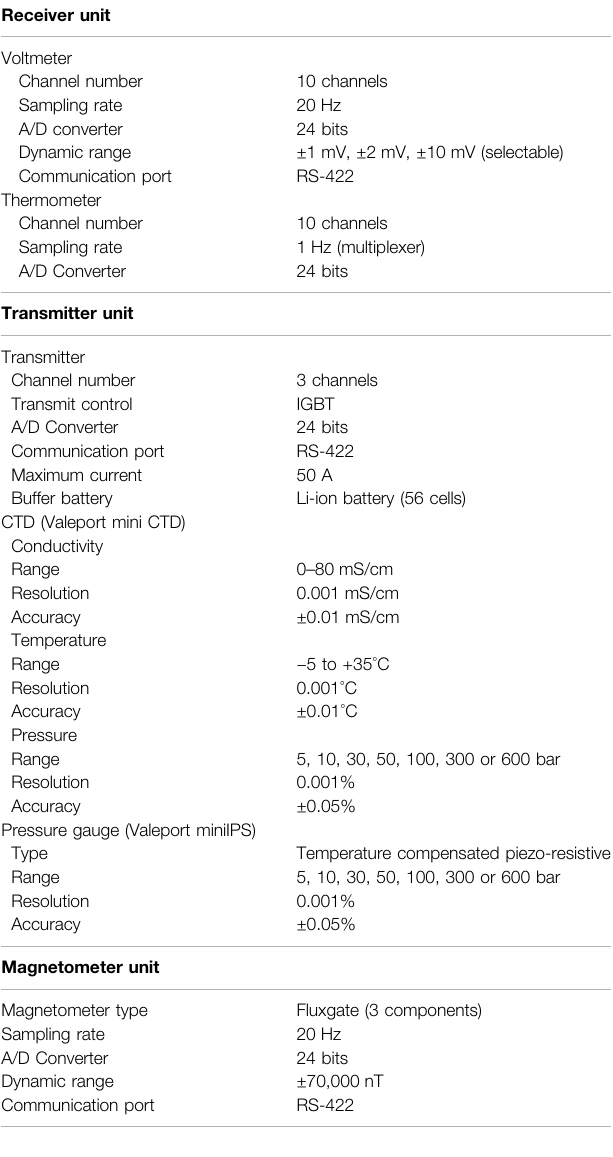
TABLE 1 | Speci fi cations of observation